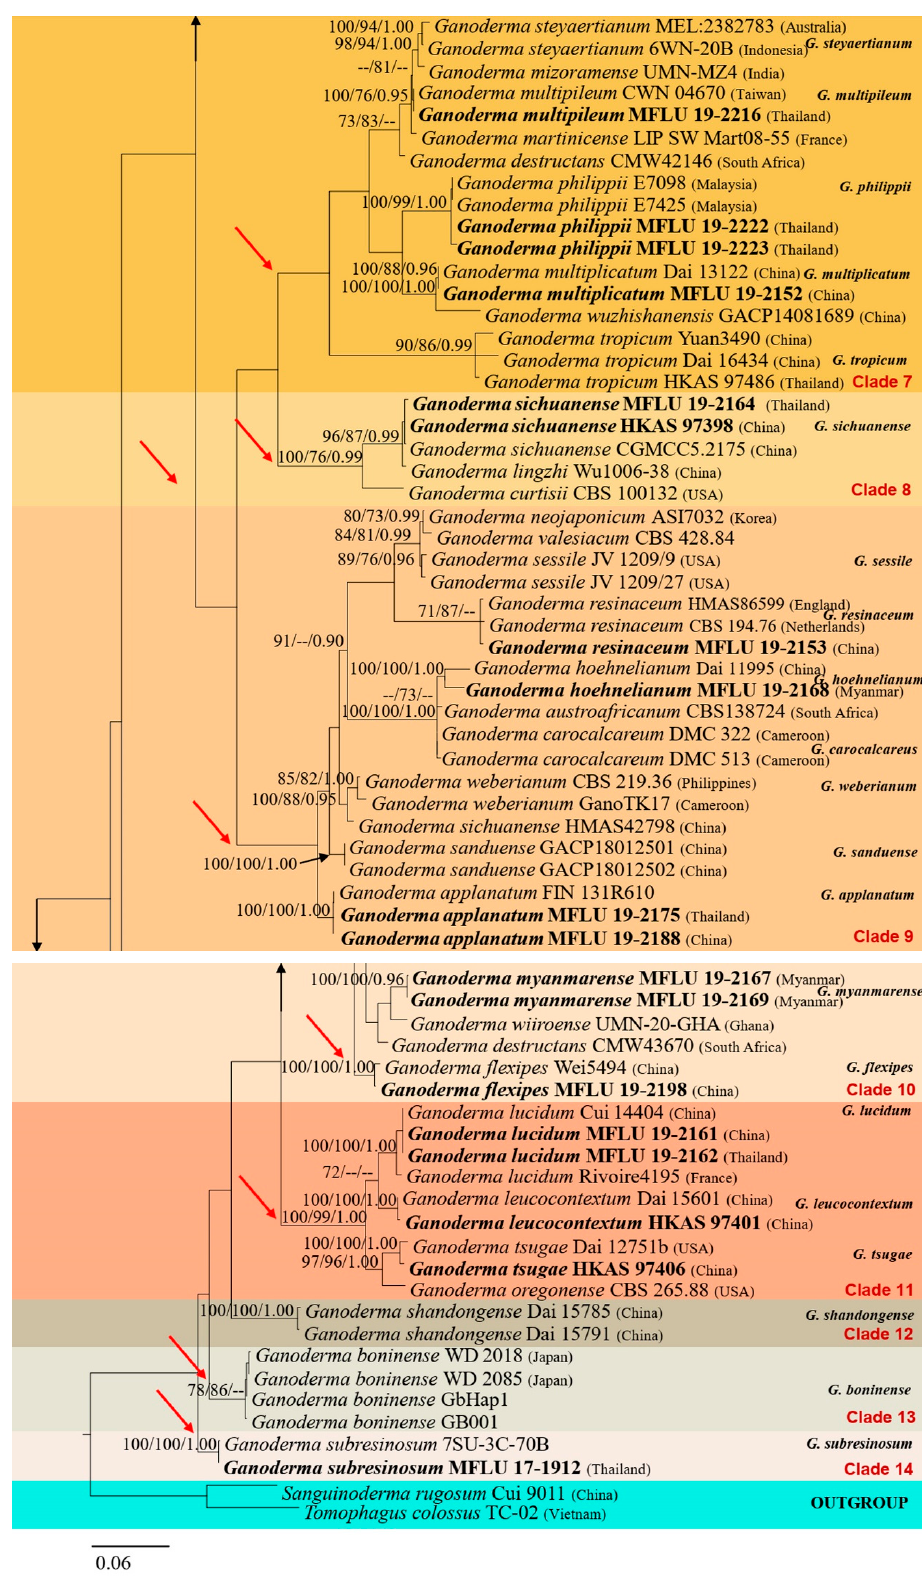
Figure 3. Maximum likelihood phylogenetic tree ML obtained from the DNA sequence data of ITS, LSU, RPB2, and TEF1 α data sets. Bootstrap values BS from maximum likelihood ML, left, maximum parsimony MP, middle, equal to or greater than 70% and Bayesian posterior probabilities PP, right, equal to or greater than 0.95 are indicated above or below the nodes as MLBS/MPBS/PP. The tree is rooted with Sanguinoderma rugosum Cui 9011 and Tomophagus colossus TC-02. New species, new record species, and known species obtained in this study are indicated in bold black .